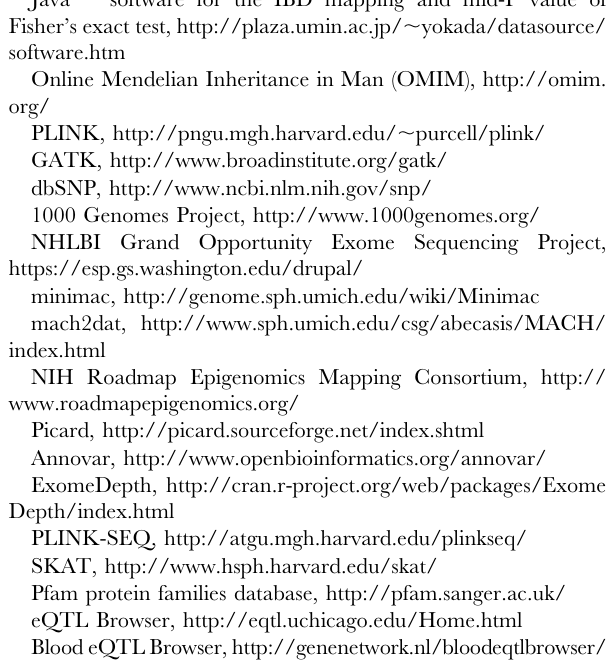
Figure S1 Protein structure of PLB1 and RA risk variant. PLB1 protein has three GDSL-like lipase